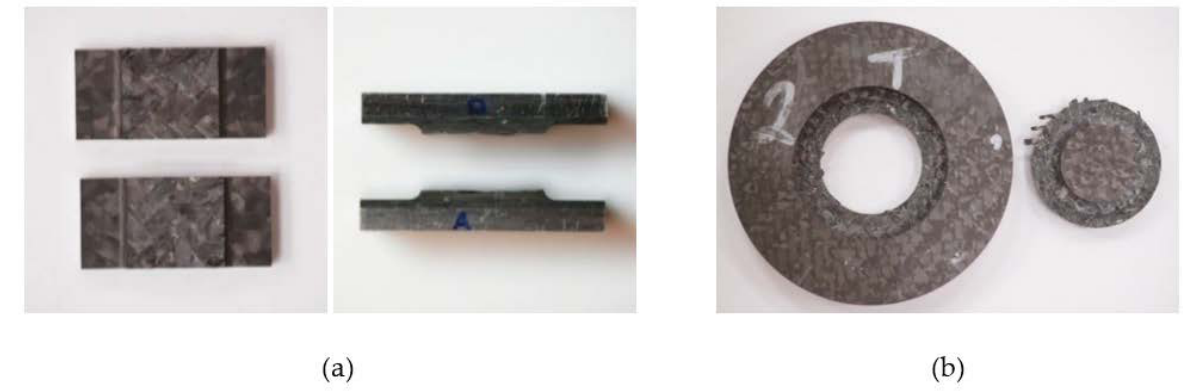
Figure 9. Images of failed indirect geometries: ( a ) cruciform and ( b )